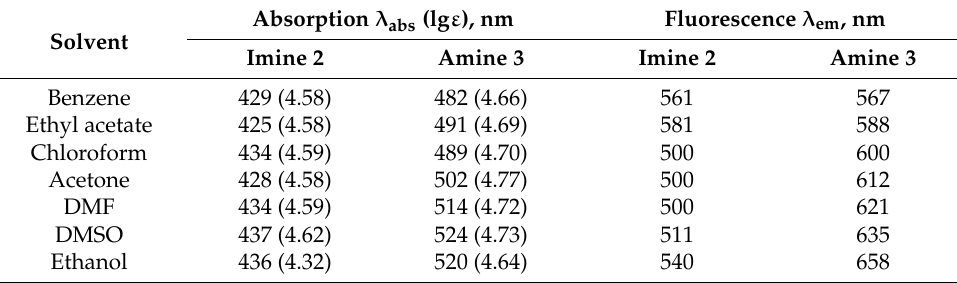
Table 1. Photophysical parameters of studied derivatives in various solvents.